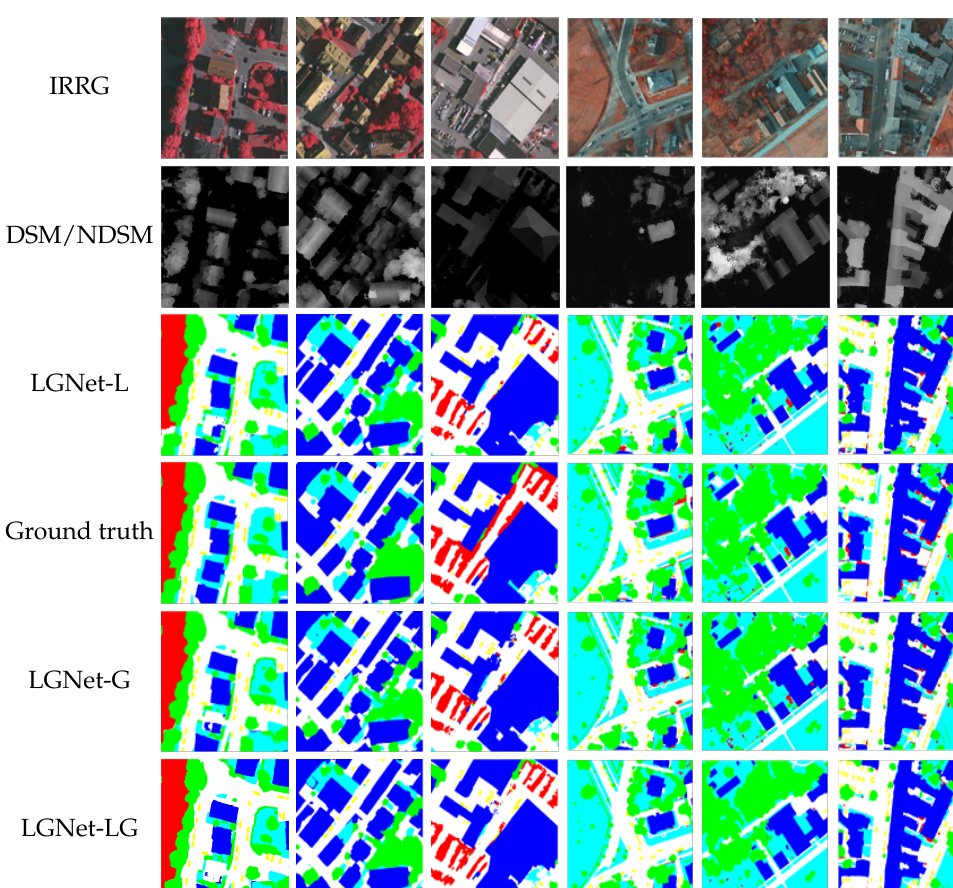
Figure 8. Some samples of the test set of the LGNet-L, LGNet-G and LGNet-LG on the ISPRS Vaihingen and Potsdam